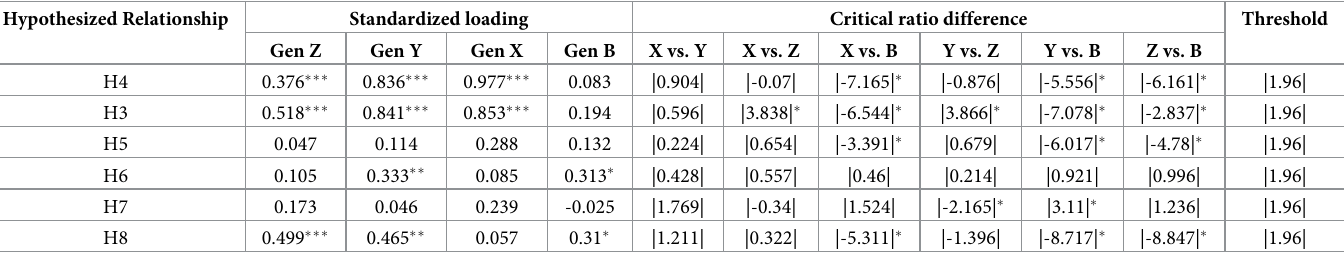
Table 7. Multigroup structural model and critical ratio